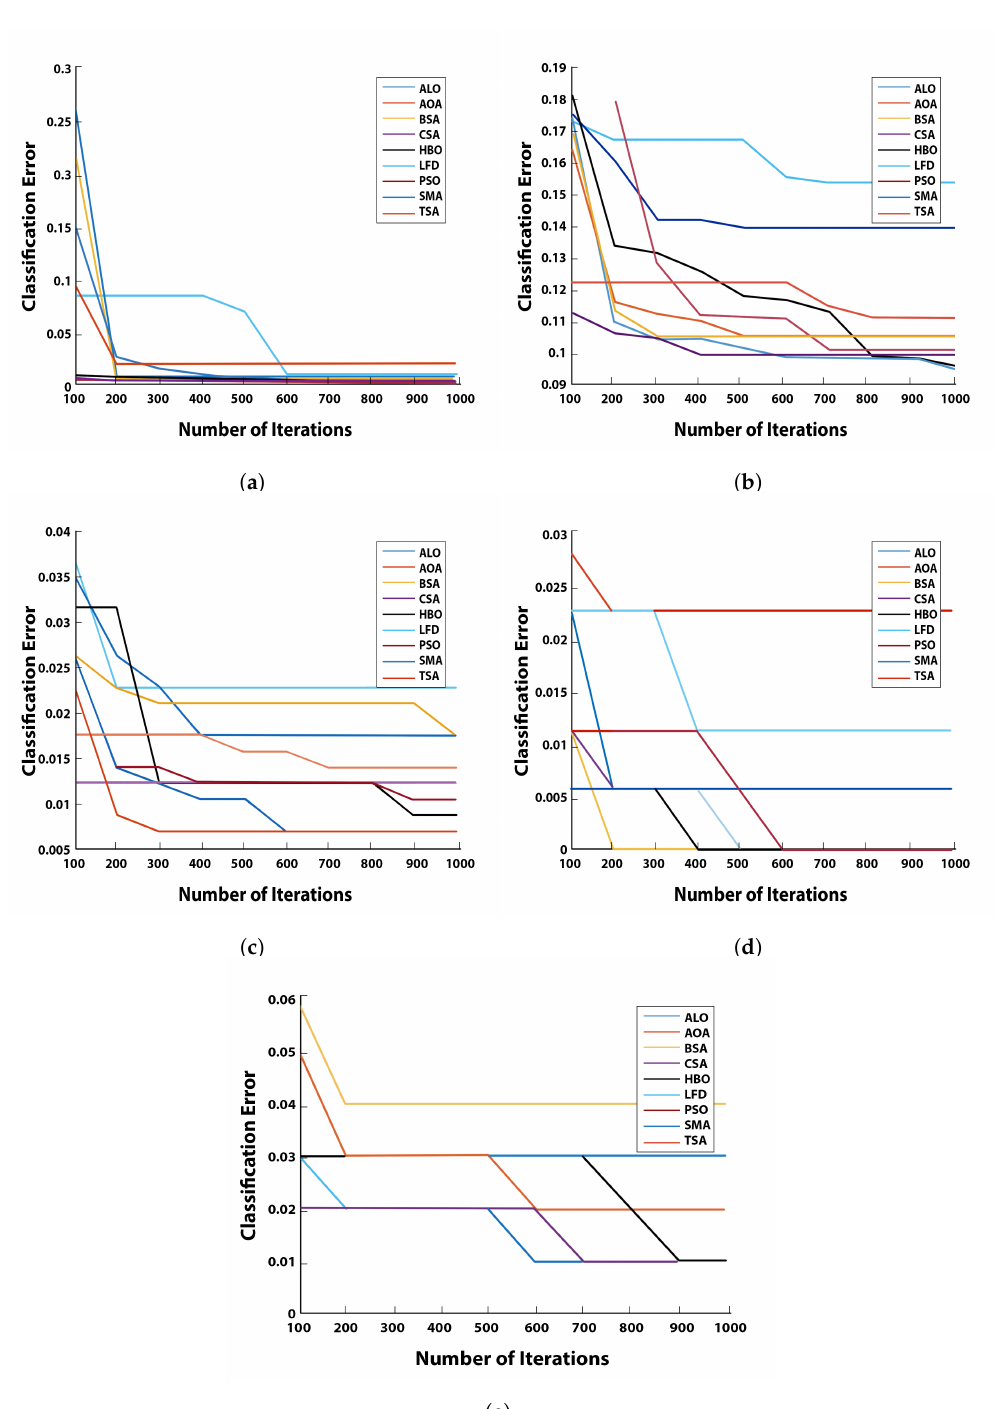
Figure 5. ( a ) Convergence Curve of the proposed approach for Vowel dataset; ( b ) Convergence Curve of the proposed approach for WaveformEW dataset; ( c ) Convergence Curve of the proposed approach for WDBC dataset; ( d ) Convergence Curve of the proposed approach for Wine dataset; ( e ) Convergence Curve of the proposed approach for Zoo